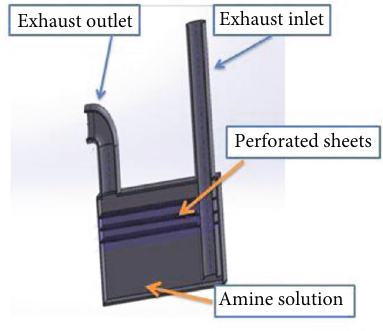
Figure 4: The design model of CO